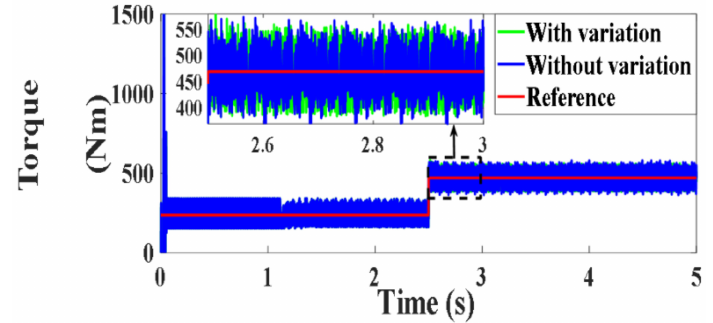
Figure 123. Developed torque under PVC (Nm).